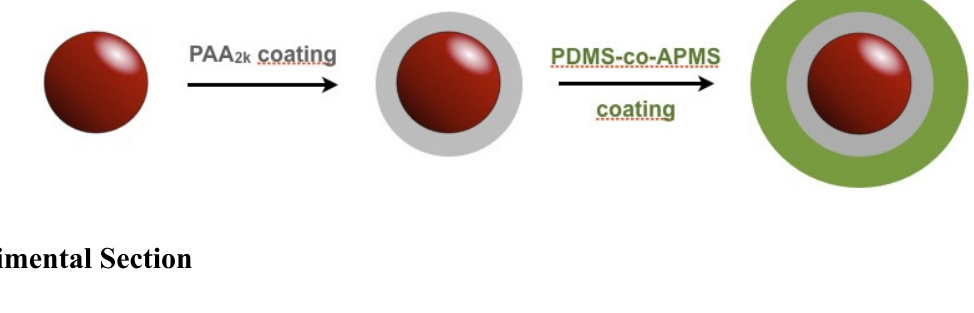
Figure 1. Scheme of the PAA2k and PDMS-co-APMS coating on iron oxide